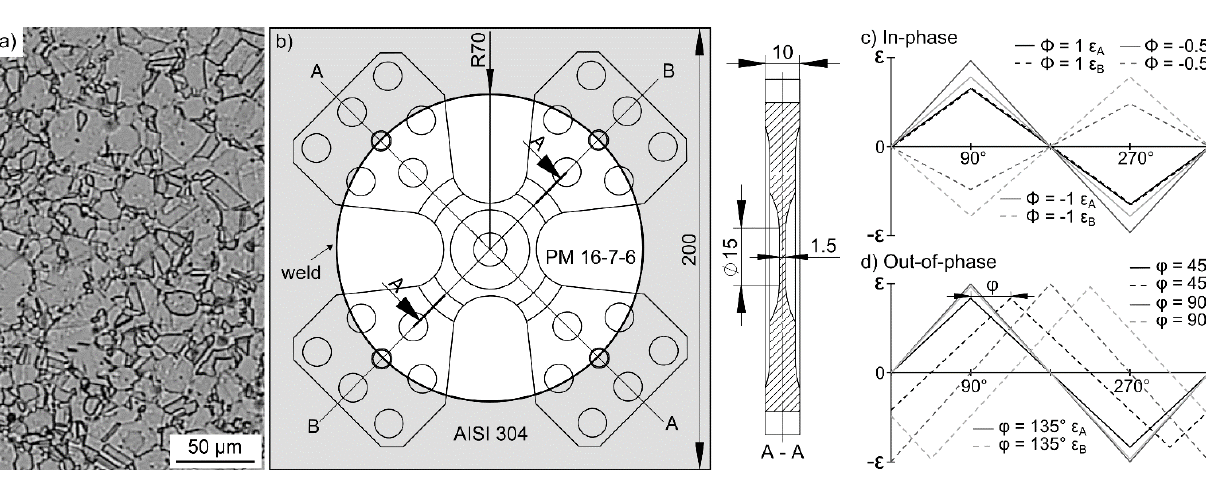
Figure 1: a) Initial austenitic microstructure of the investigated TRIP steel PM 16-7-6. b) Cruciform specimen and position of the weld in case of PM 16-7-6. Schematic courses of control signals of axial strains  A and  B for different c) strain ratios  (in-phase tests)